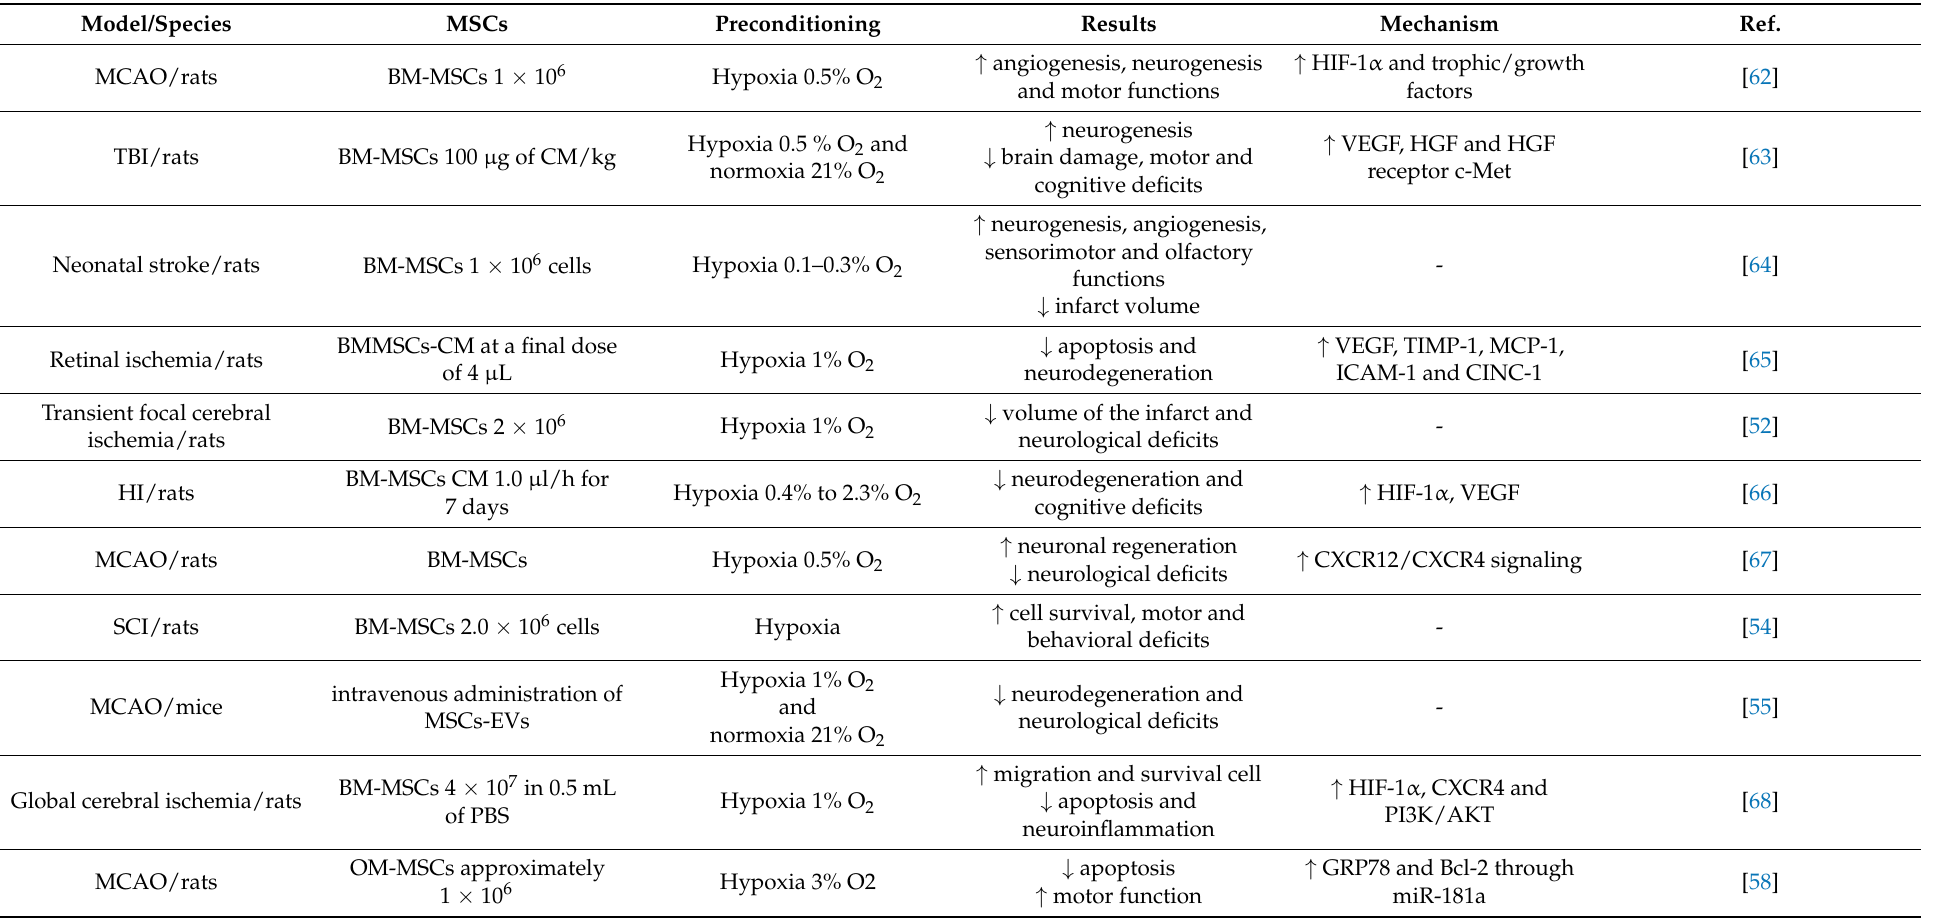
Table 3. Summary of the in vivo studies that reported the effects of hypoxic preconditioning of